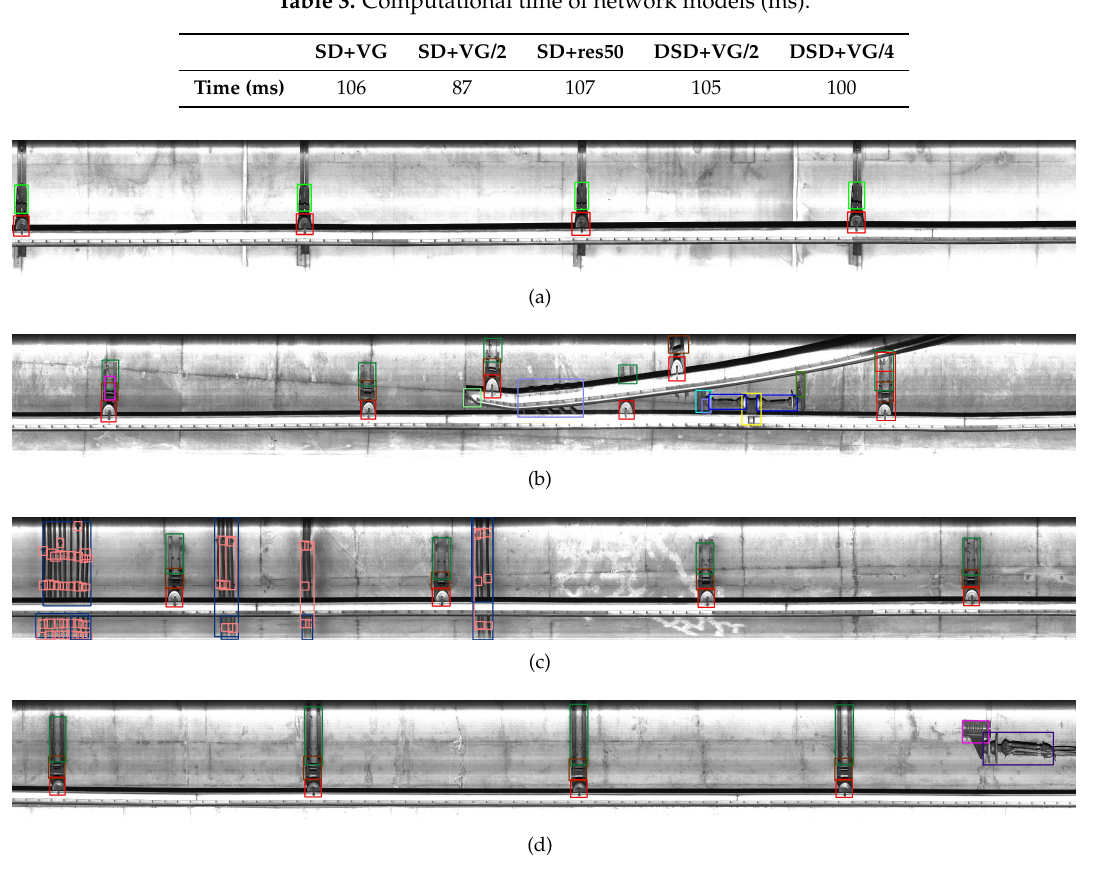
Figure 13. Detection results using the proposed network: ( a – d ) are results of the 1st, 16th, 20th, and 82th frame, respectively. Color of bounding boxes represents each class type as shown in Figure